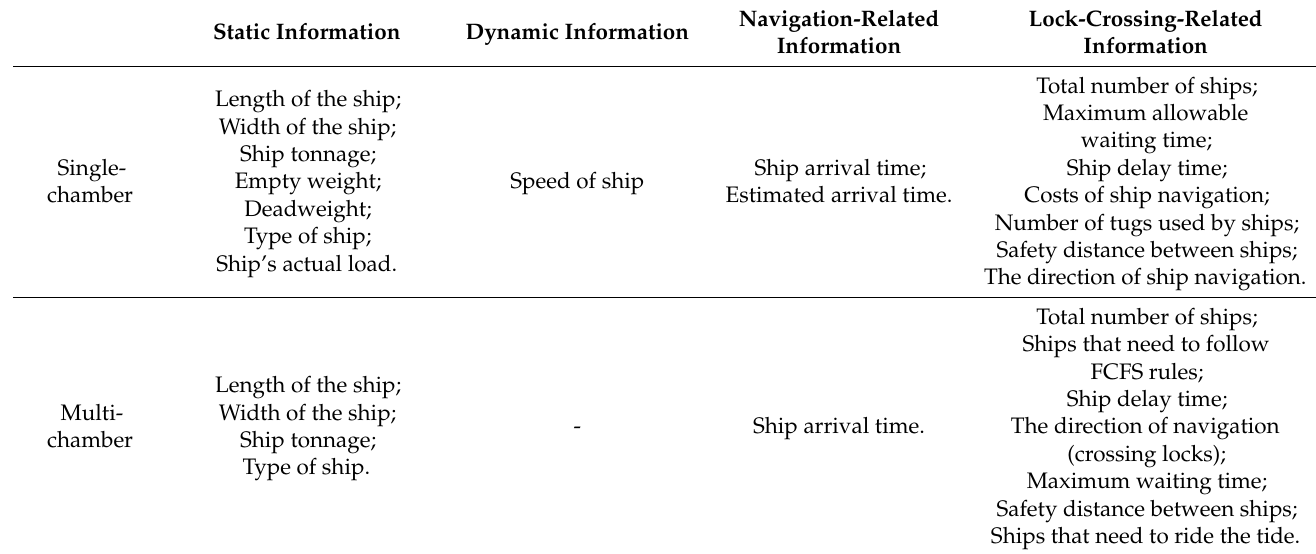
Table 2. Information in the lock scheduling